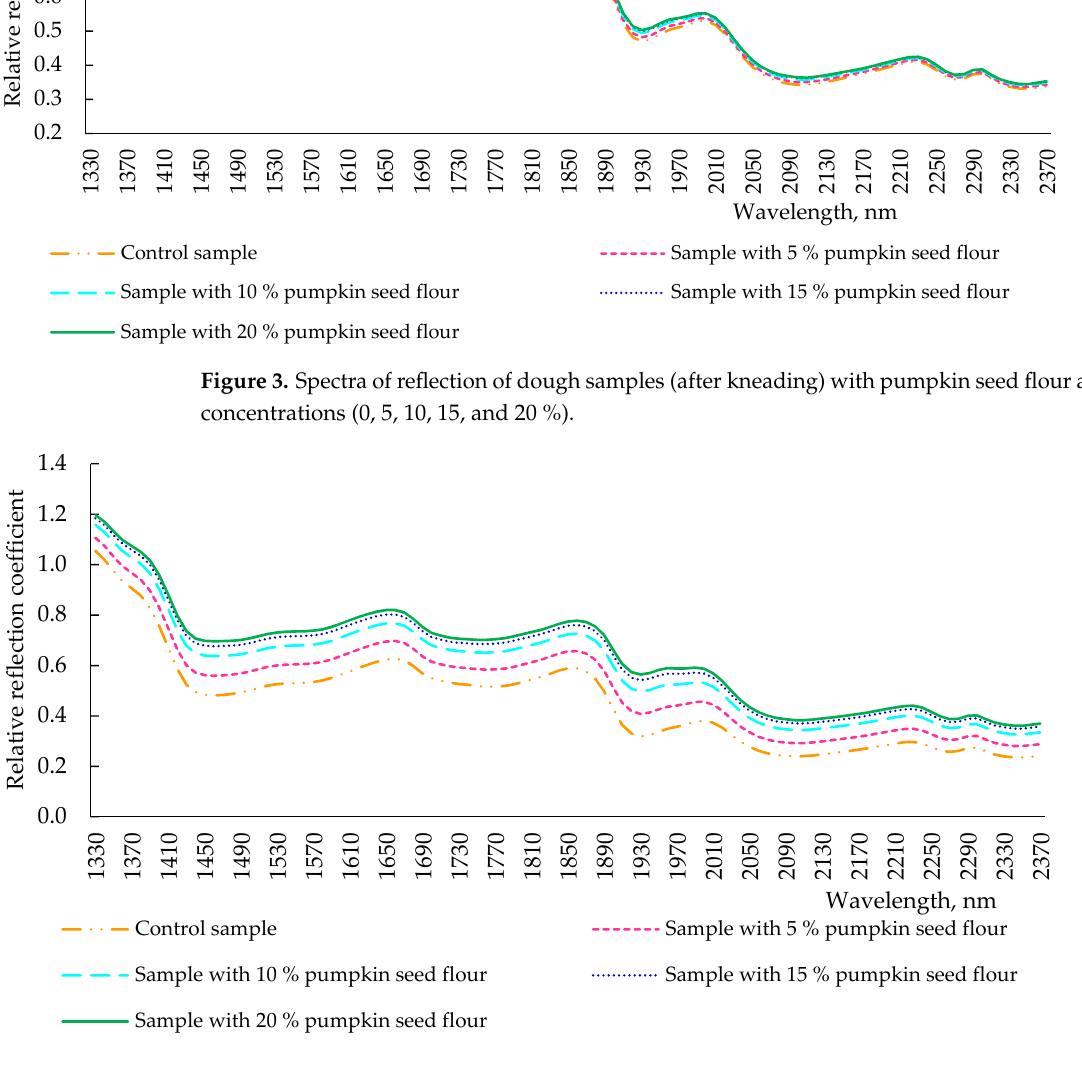
Figure 4. Spectra of reflection of dough samples (after 3.5 h of fermentation) with pumpkin seed flour at different concentrations (0, 5, 10, 15, and 20%).